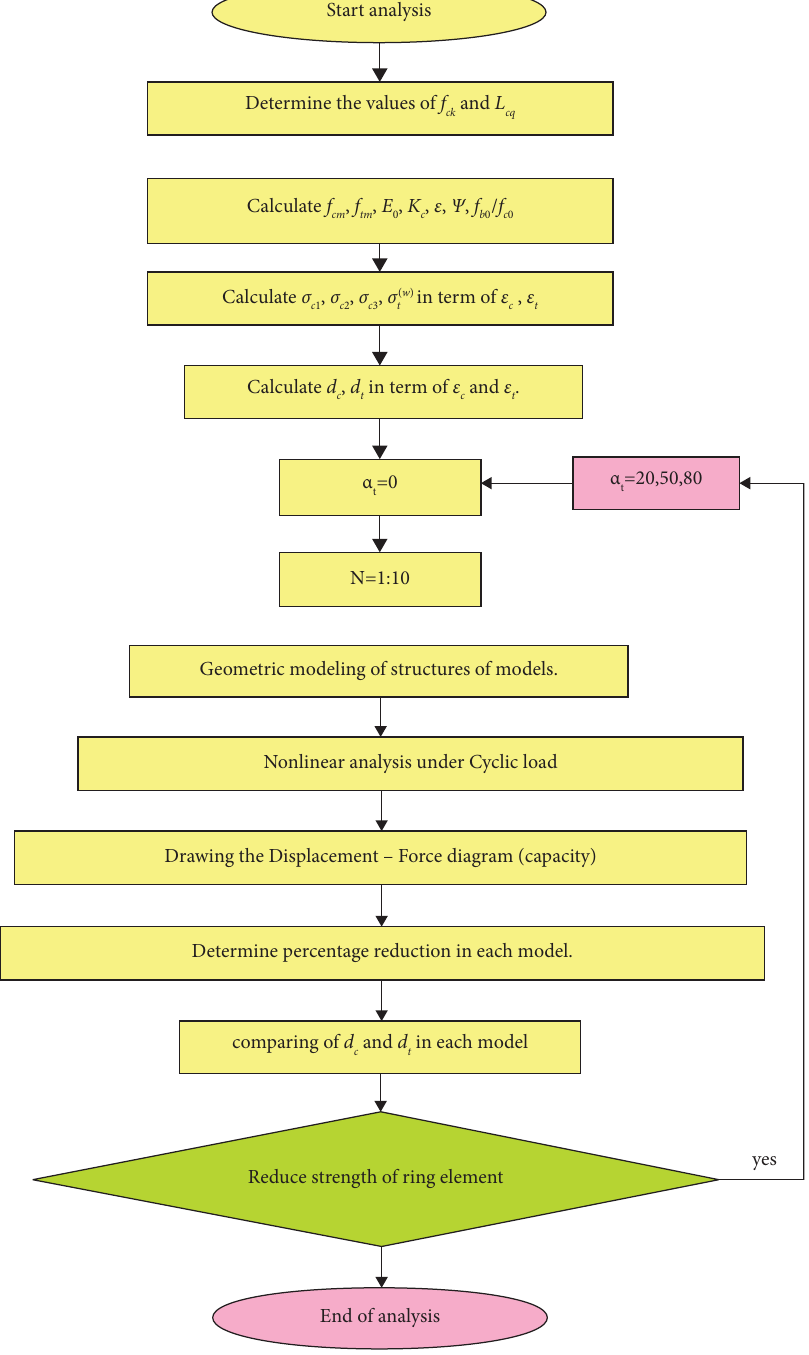
Figure 11: Step-by-step process of FEM